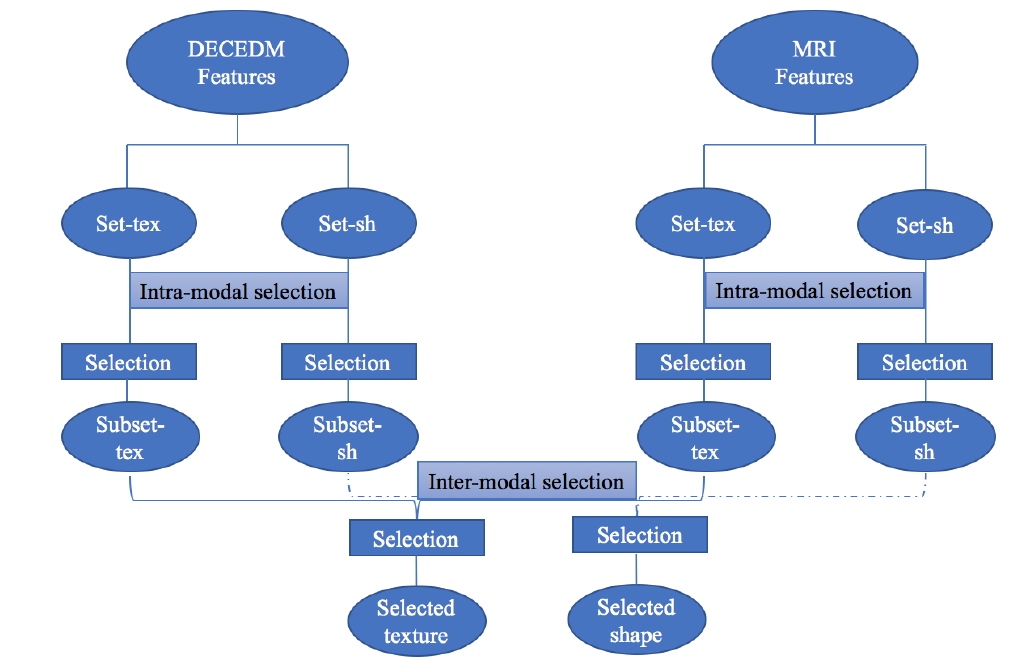
Figure 3. An overview of the proposed hierarchical selection